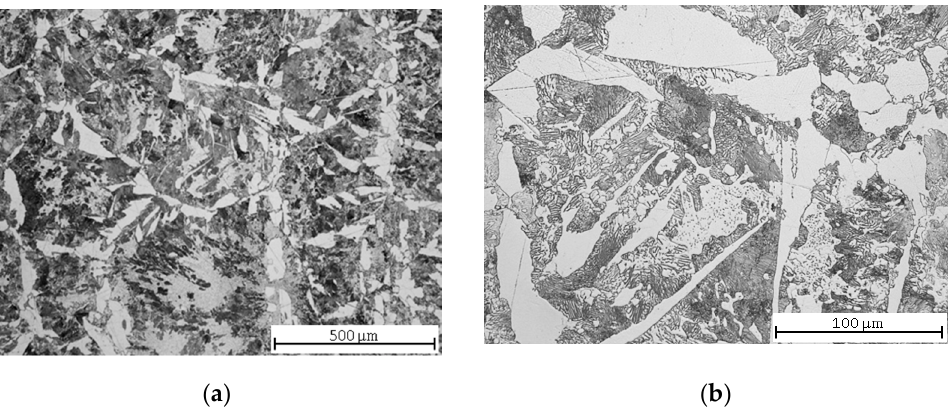
Figure 2. C45 steel microstructures after soft annealing: ( a ) central part; ( b ) detail.